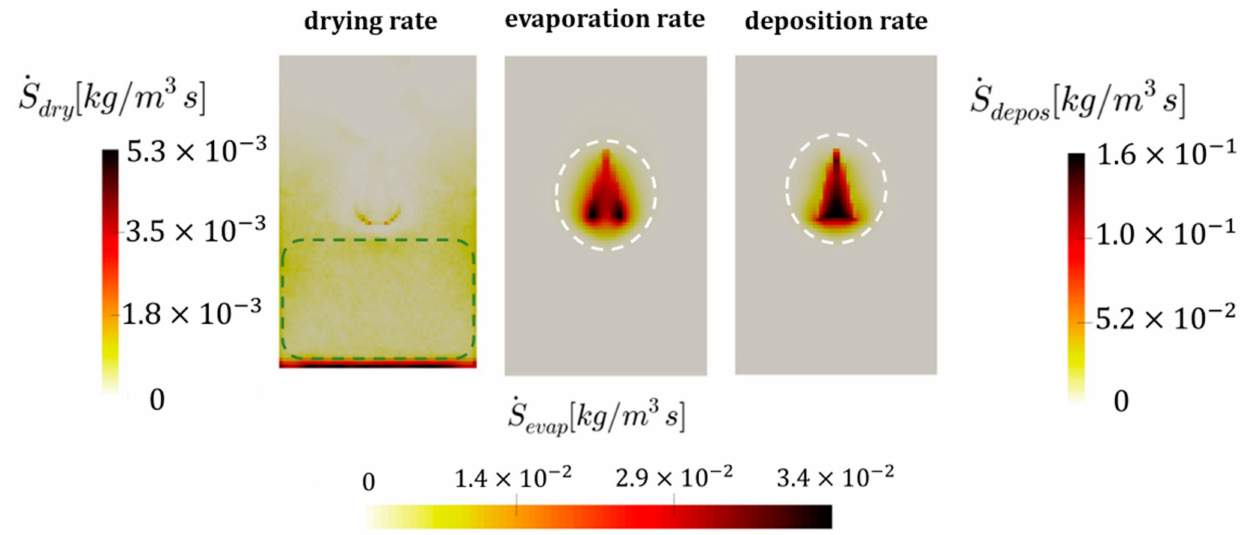
Figure 9. Identification of different zones in a typical 2D wet fluidized bed (the result of TFM simulations following Askarishahi et al.